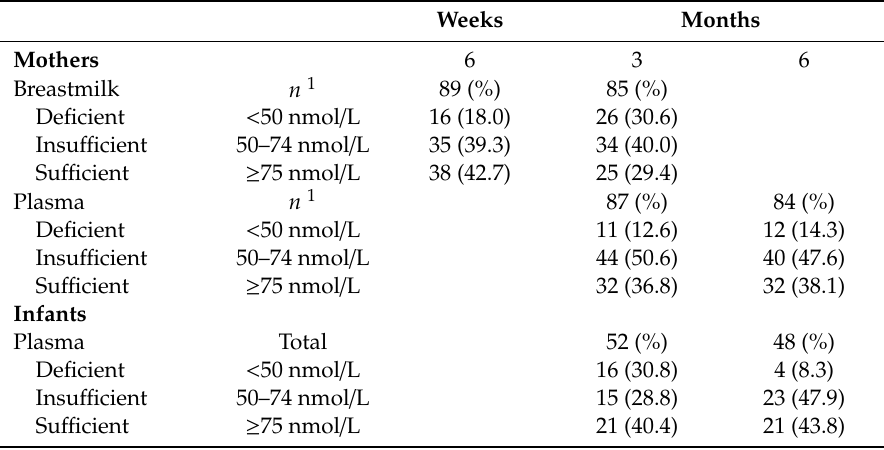
Table 4. Distribution of vitamin D status at each time-point (6 weeks, 3, and 6 months) for maternal and infant samples.